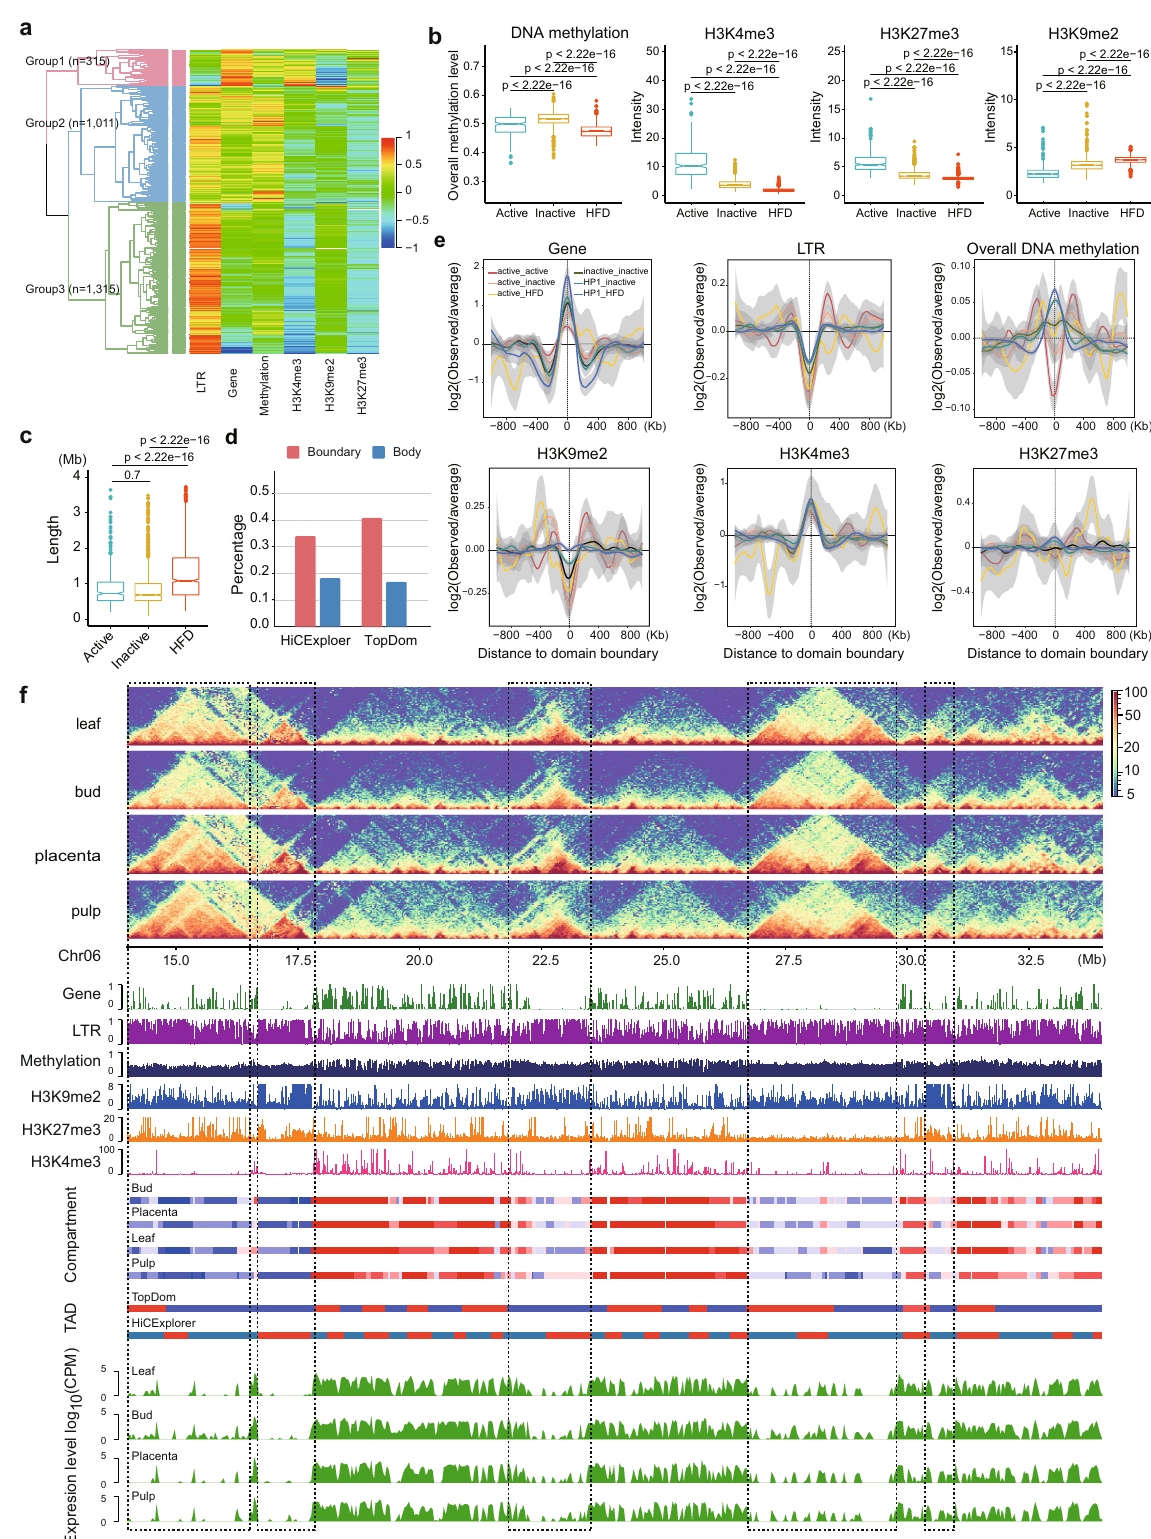
types. Generally, boundaries of active domains had lower levels of DNA methylation compared to their fl anking regions, while boundaries of inactive and HDF domains had higher levels of DNA methylation (Fig. 4e). Heterochromatin has recently been proposed as an important driving force of 3D genome folding of eukaryotic genomes 61 – 63 .